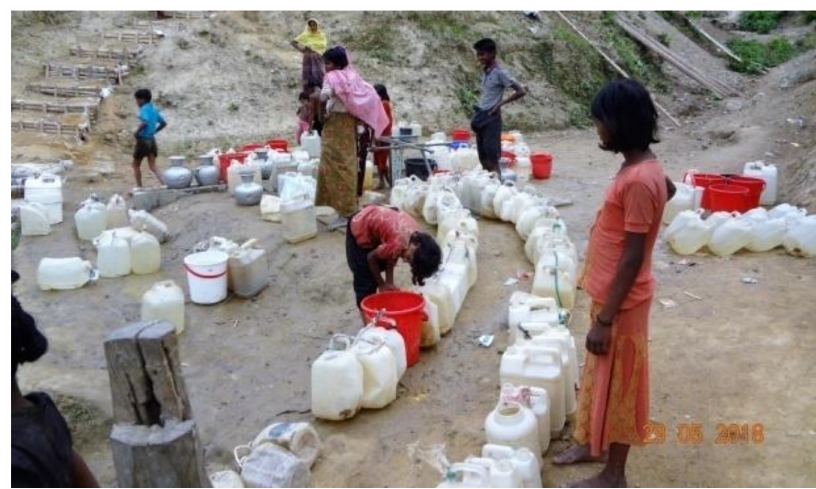
Figure 2. Queue for drinking water collection in Camp 26.